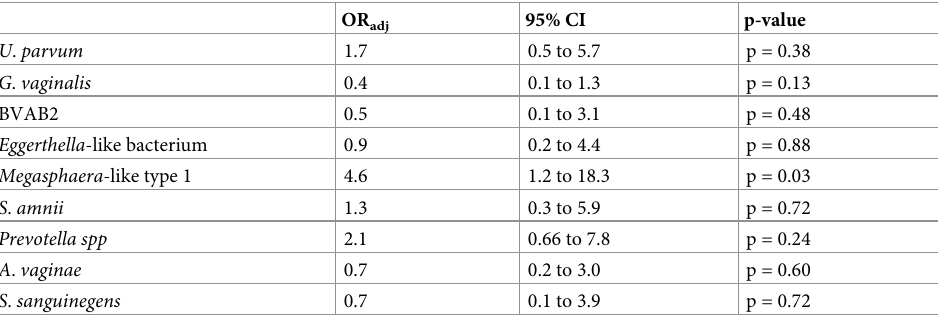
Table 3. Adjusted odds ratios (ORadj) with 95% confidence intervals (CI) and p-values in asymptomatic male controls (n = 97) and in men with symptomatic idiopathic urethritis (n = 20) after multivariate logistic regression analysis for eight bacterial vaginosis associated bacteria and Ureaplasma parvum